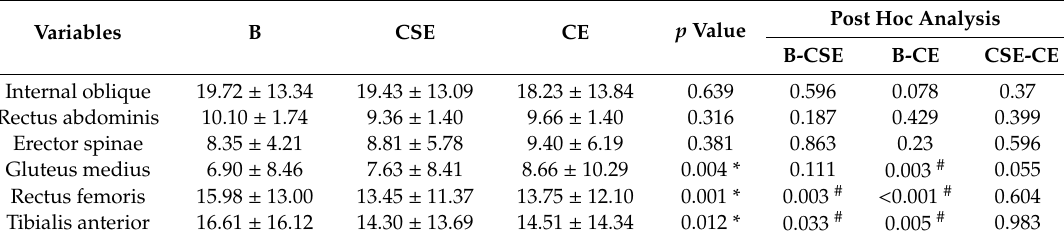
Table 4. Comparison of muscle activation in the eye-opened